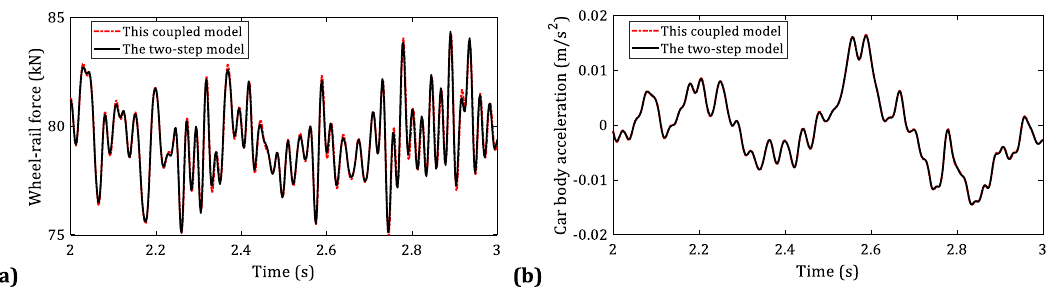
Fig. 22 Comparisons on vehicle-related response indices: a wheel-rail vertical force; b car body vertical acceleration